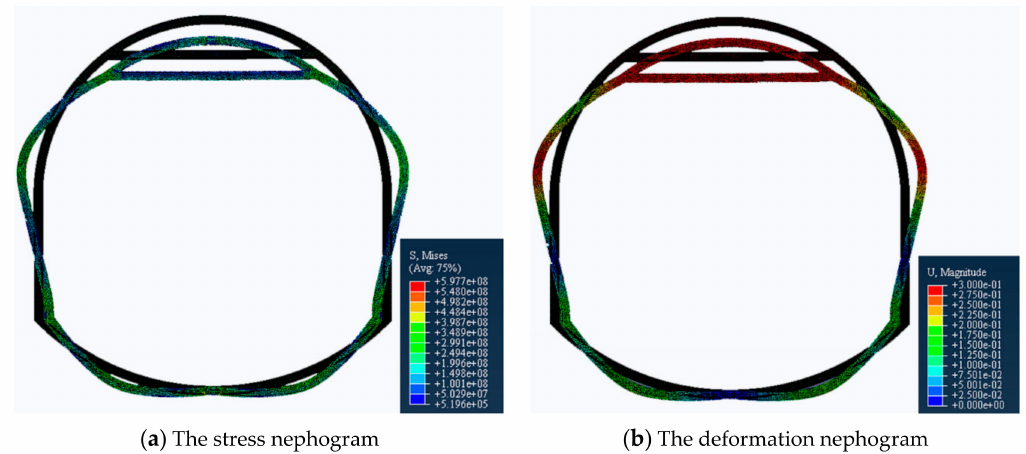
Figure 10. The stress nephogram and the deformation nephogram of RB set I.